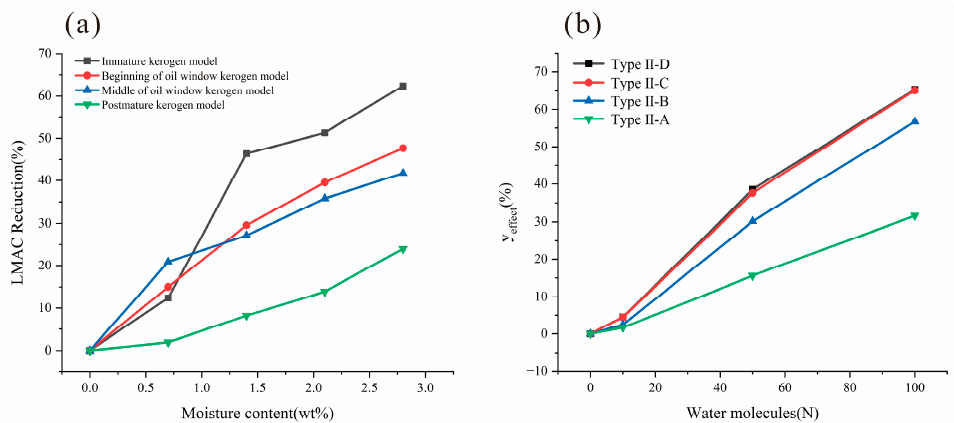
Figure 6. ( a ) The reduction in the Langmuir maximum methane adsorption capacity (LMAC) of kerogen models of different maturities with increasing moisture content. The LMAC reduction is defined as the ratio of reduced LMAC at a certain moisture content to the LMAC under dry conditions. The data are from [178]. ( b ) Degree of influence of water on the methane adsorption capacity under different water molecular weight conditions. y effect = (methane adsorption capacity in the absence of water—methane adsorption capacity in the presence of water)/methane adsorption capacity in the absence of water ×100%. N is the number of water molecules in the kerogen. The four kerogen models (II-A, II-B, II-C and II-D) correspond to the four stages of thermal maturation (low-, middle-, high- and over-mature). The data are from [179].